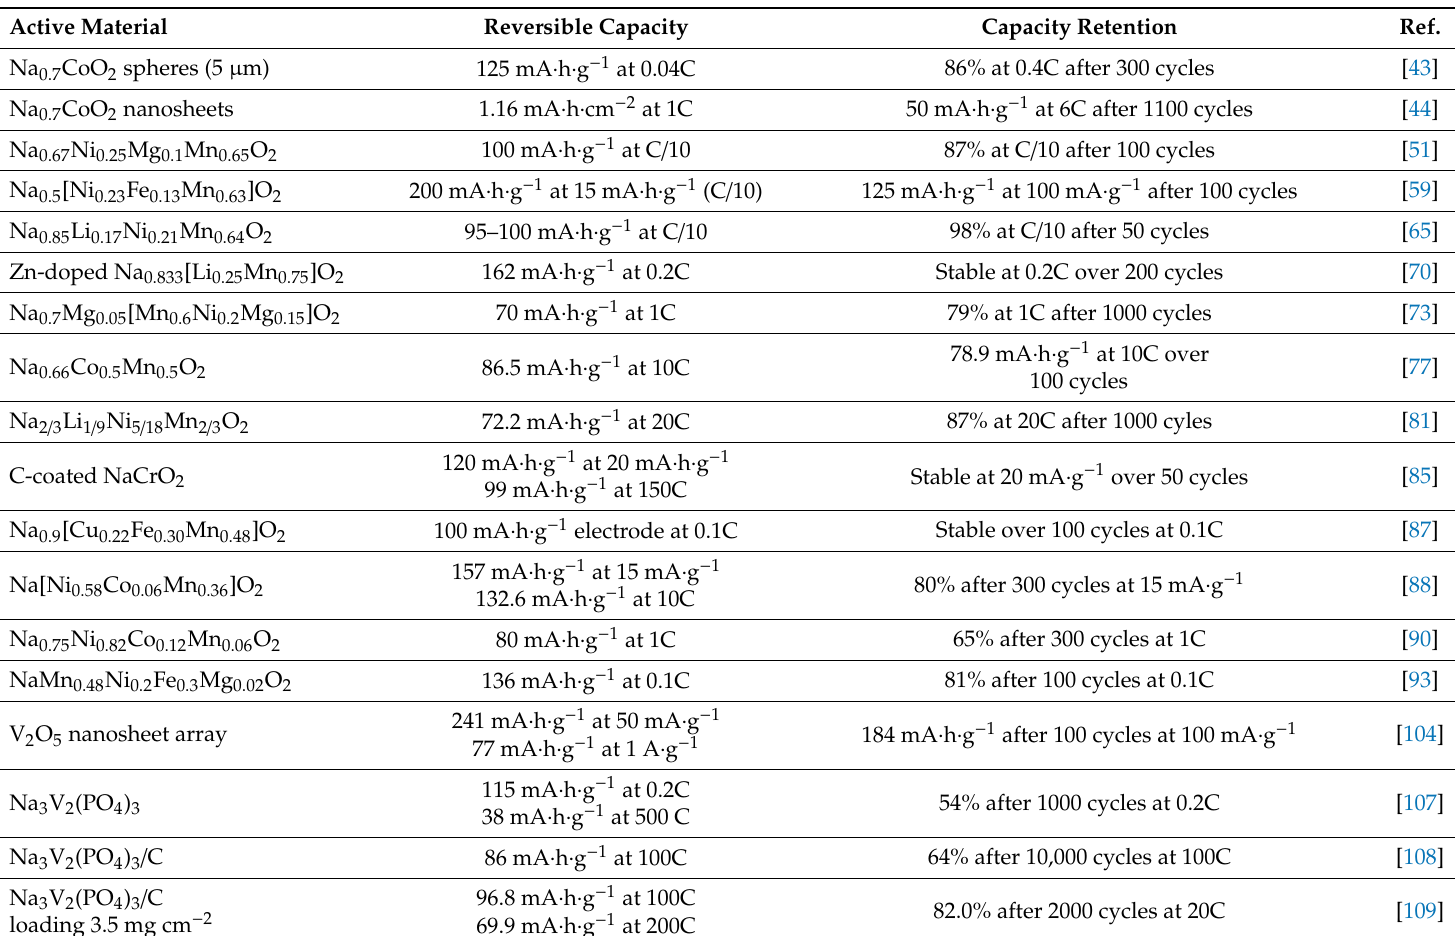
Table 1. Electrochemical properties of selected cathode-materials reviewed in the text, including P2-layered oxide materials (from ref. [43–81]), O3-layered oxide materials (from ref. [85–93]), another oxide (V 2 O 5 ), polyanionic compounds (from ref. [107–131]), Prussian blue analogs (from ref.